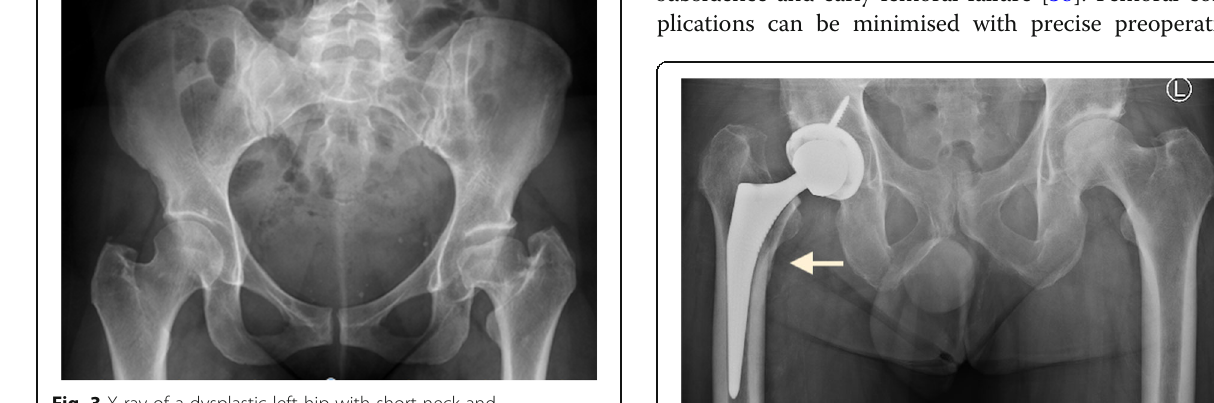
Fig. 3 X-ray of a dysplastic left hip with short neck and flattened head